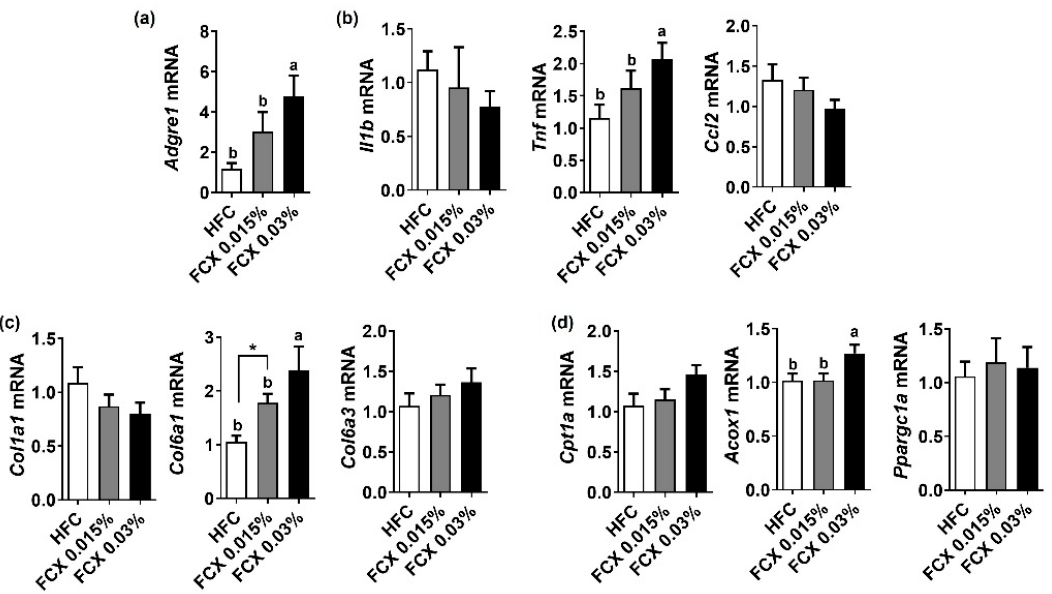
Figure 4. Effect of FCX on the expression of inflammation, profibrogenic, and β -oxidation genes in the eWAT of DIO mice fed HFC control, FCX 0.015%, or FCX 0.03% for 12 weeks. eWAT mRNA expression levels of ( a ) macrophage marker F4/80, ( b ) inflammation genes, ( c ) pro-fibrogenic genes, and ( d ) β -oxidation genes. n = 8–11 per group. Mean ± SEM. Bars without sharing the same letter are significantly different ( p < 0.05). * p < 0.05 between two groups.